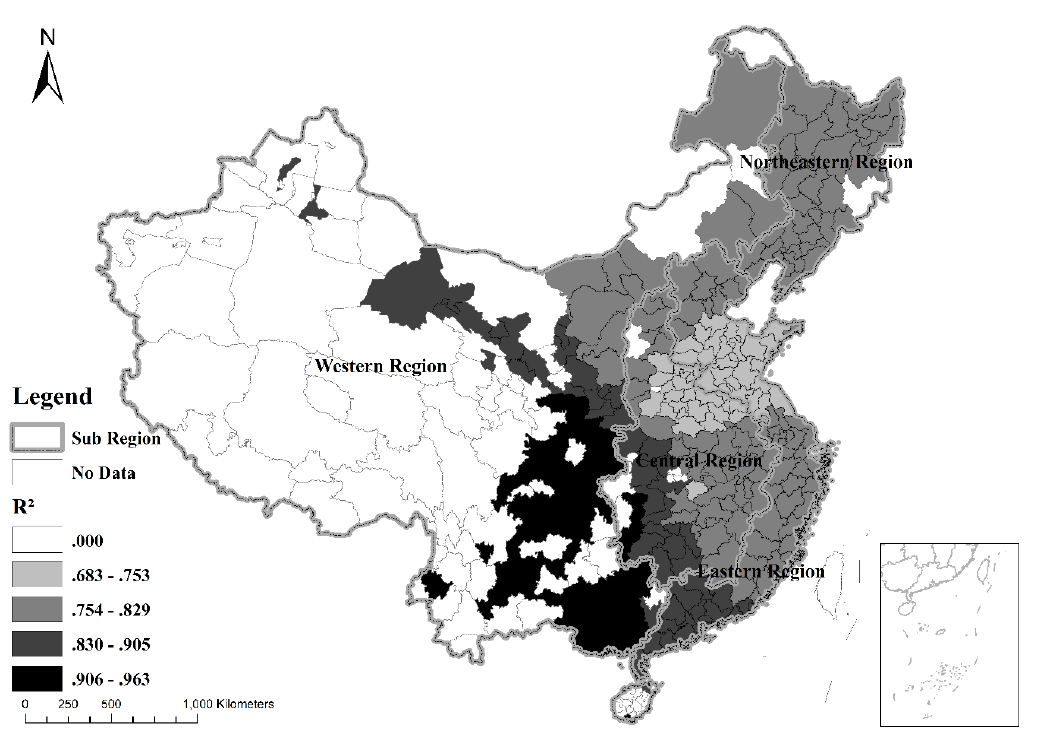
2 of the GWR Figure 5. Local R 2 of the GWR model. Figure 5. Local R